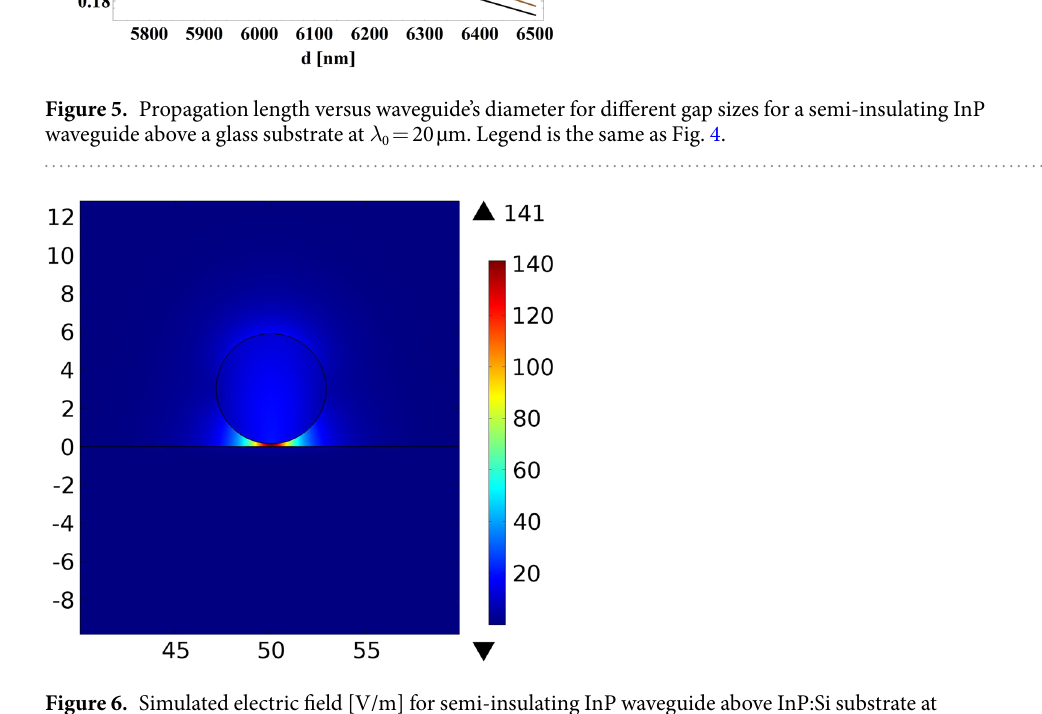
Figure 6. Simulated electric field [V/m] for semi-insulating InP waveguide above InP:Si substrate at = 20 µ m. Spatial dimensions are in µ λ 0